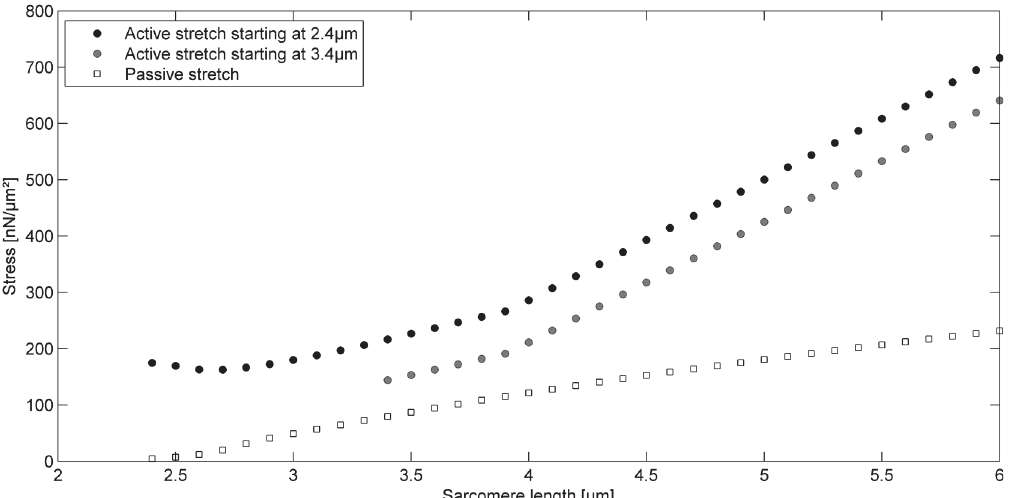
Fig 4. Force-elongation predictions of sarcomeres stretched beyond actin-myosin filament overlap. When a sarcomere is activated at 3.4 μ m and then stretched actively beyond actin-myosin overlap, its force will exceed the purely passive forces, but will not reach the high forces of sarcomeres stretched actively from optimal length.